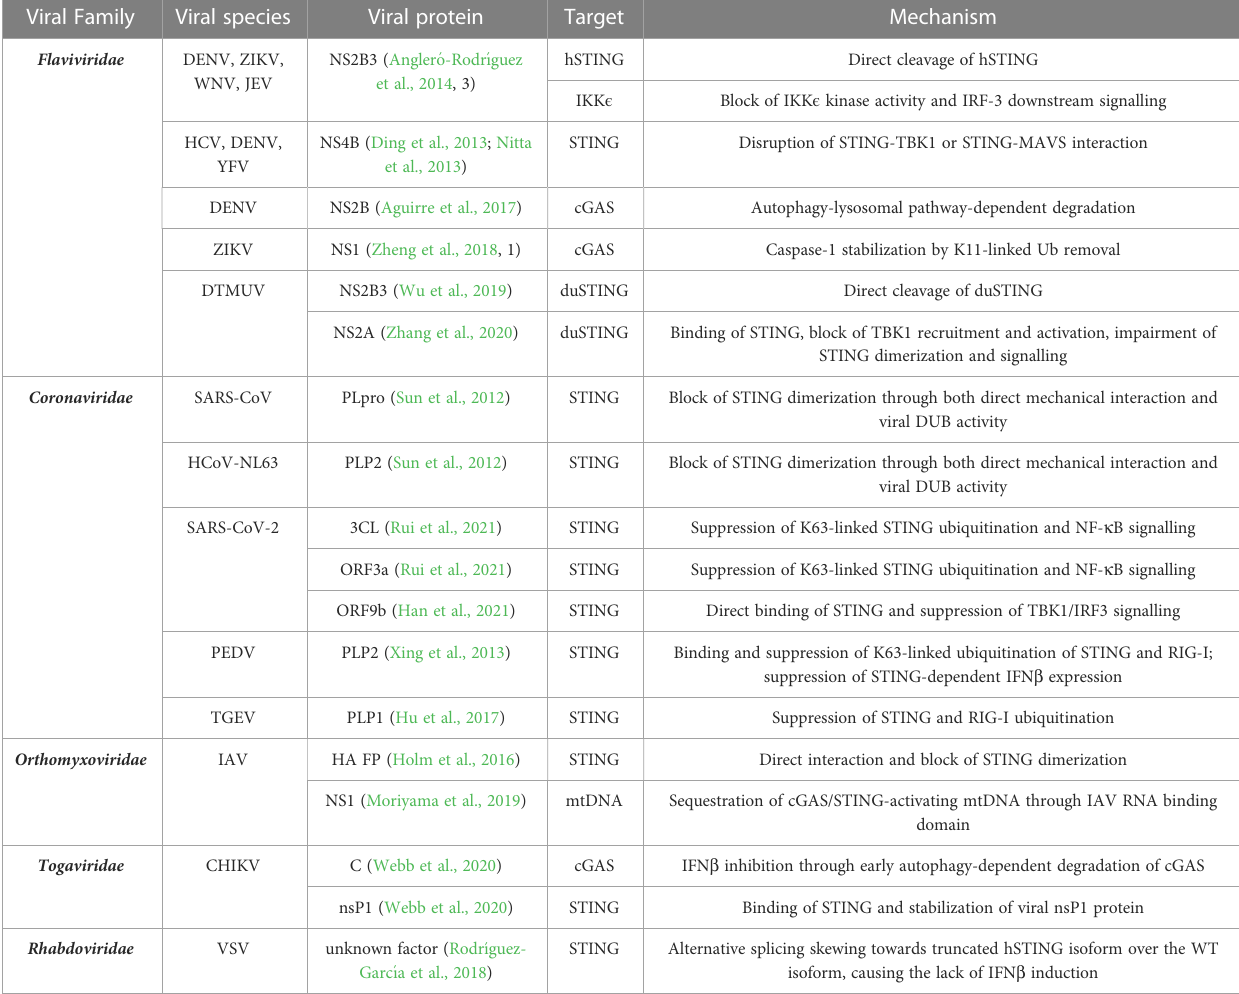
TABLE 1 RNA virus families exerting evasion strategies towards the cGAS/STING